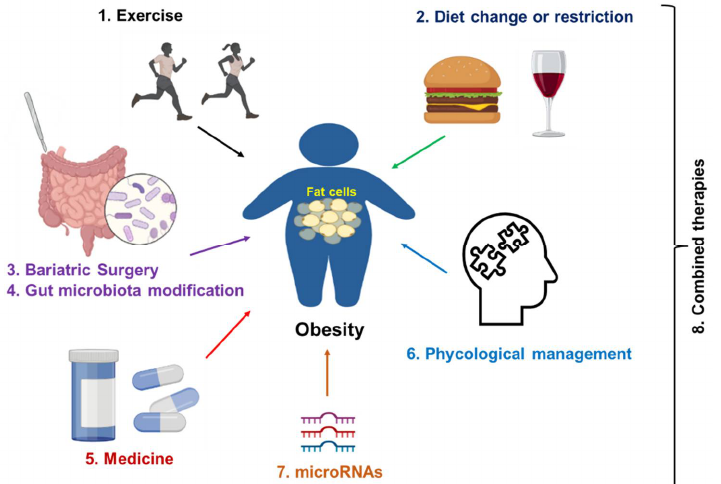
Figure 4. Strategies for obesity treatment. Exercise and dietary change or restriction are commonly applied to prevent and treat the early stage of obesity. Bariatric surgery is a commonly applied treatment for server obesity. Medicines such as semaglutide and liraglutide can be used as monotherapy or a synergistic treatment together with lifestyle management. In addition, psychological management, especially for patients with obesity and distress, is a good option. Gene regulation (microRNAs-mediated therapies) will be applied in the future. Finally, a combination of two therapies or multiple treatments from therapies 1 to 7 can be applied to improve the treatment